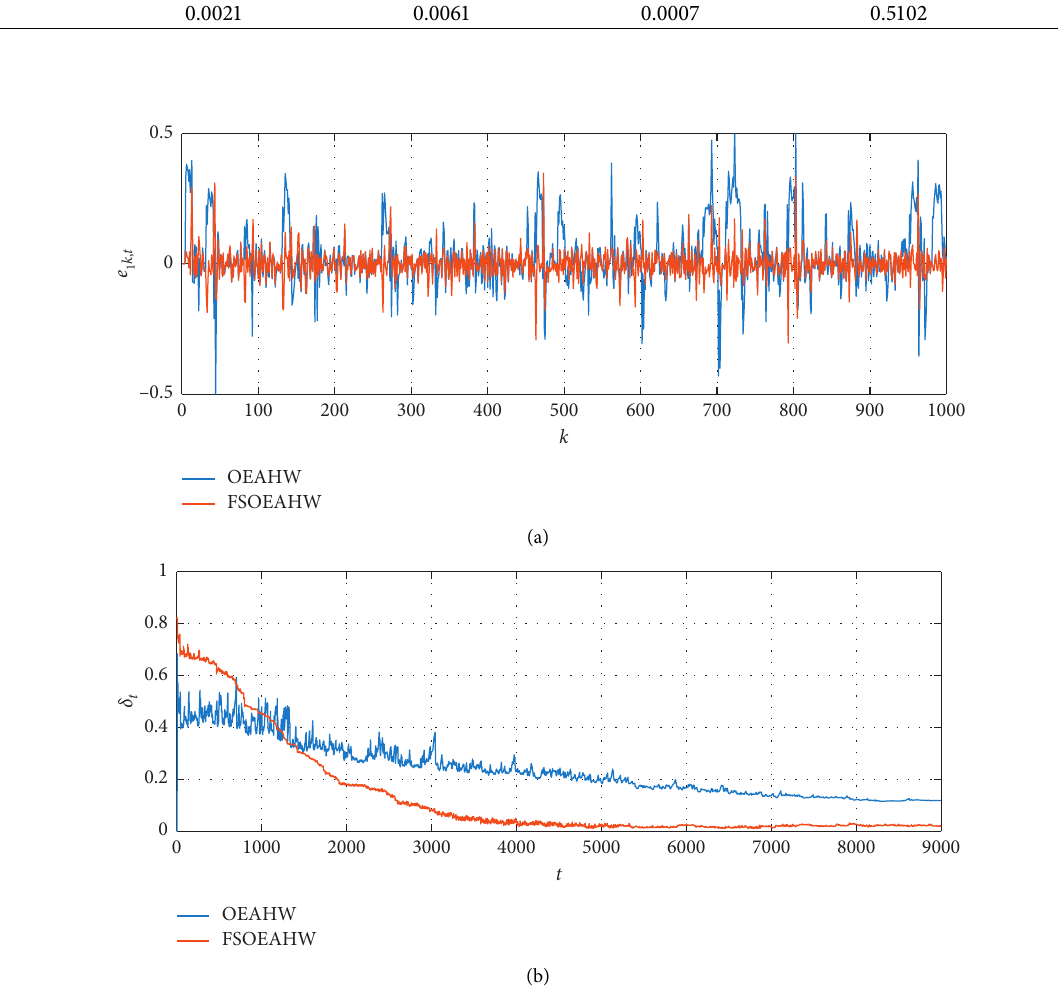
Figure 6: Evolution curves of estimation error (a) and parametric error (b) for the FSOEAHW and OEAHW models.